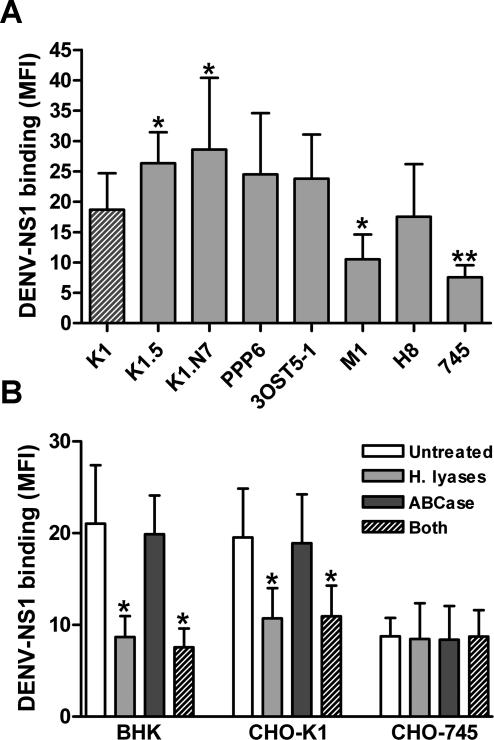
Binding of DENV NS1 to Cell Surface Is GAG-Dependent(A) DENV NS1 binding to wild type (K1) and seven mutant CHO cell lines that overexpress (K1.5, K1.N7, PPP6, and 3OST5–1) or are defective (M1, H8, and 745) for specific enzymes in GAG synthesis. Binding and staining were performed at 4 °C and analyzed by flow cytometry. Data are expressed as the specific MFI of staining after subtraction of background antibody binding in the absence of NS1. The error bars indicate standard deviation (SD) corresponding to three independent experiments. Asterisks note NS1 binding that is statistically different from the CHO-K1 wild-type cells (* p < 0.05, ** p < 0.005).(B) Cell surface HS and CS were enzymatically removed from BHK or wild-type CHO-K1 cells after treatment with a mixture of heparin lyases I, II, III (H. lyases) or chondroitinase ABC (ABCase) and assayed for binding of DENV NS1. A GAG-negative mutant cell (CHO-745) was used as a negative control. Analysis was performed by flow cytometry. Data are expressed as the specific MFI of staining after subtraction of background antibody binding in the absence of NS1. The error bars indicate SD corresponding to three independent experiments. Asterisks indicate DENV-2 NS1 binding that is statistically different from untreated cells (* p < 0.05, ** p < 0.005).